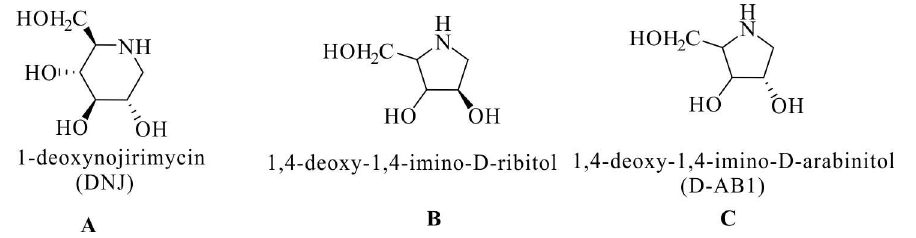
Fig 1. Molecularstructures of 1-deoxynojirimycin(A), 1,4-dideoxy-1,4-imino-D-ribitol(B), and D-AB1 (C).